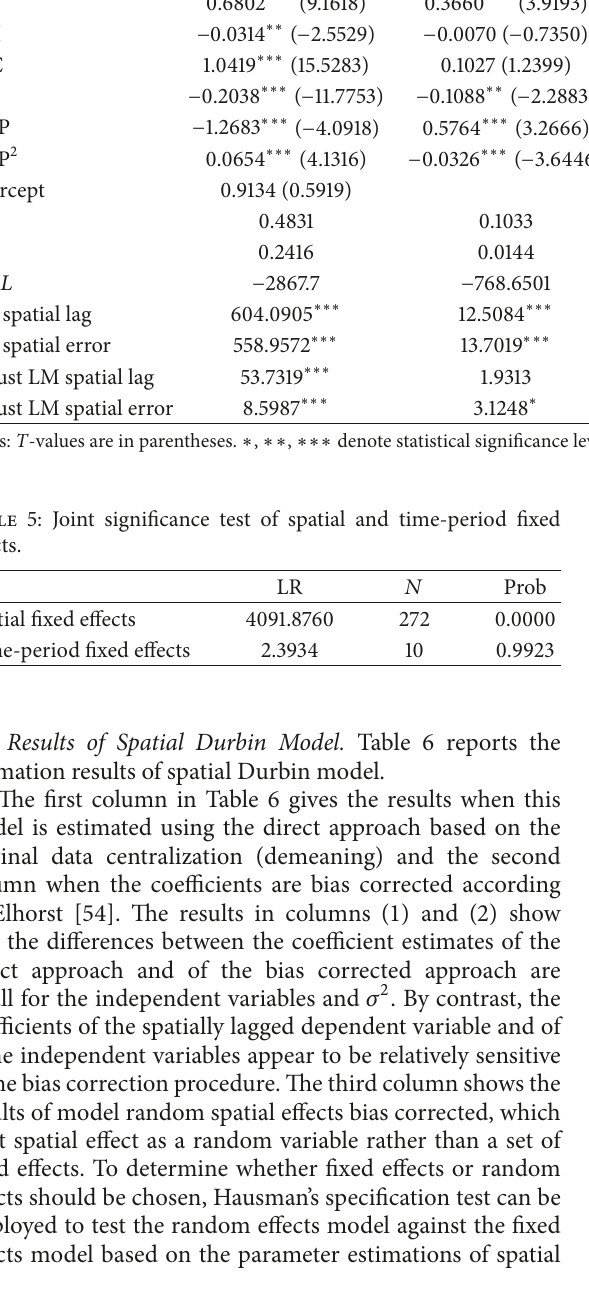
Table 4: Estimation results of panel data models without spatial interaction effects. Pooled OLS